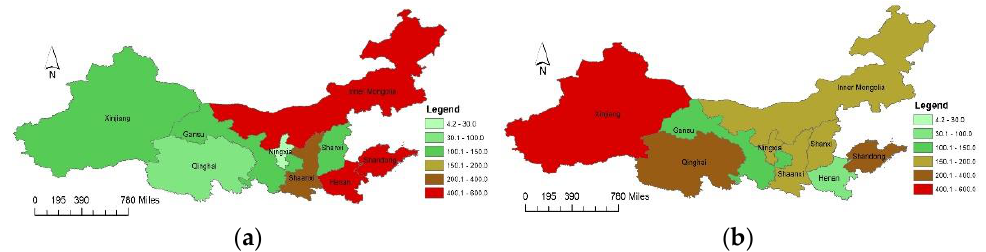
Figure 5. Virtual water trade of each province in the Yellow River Economic Belt (( a ) Total virtual water inflow and ( b ) Total virtual water outflow). Source: Authors’ own calculation / conception, based on MATLAB and ArcGIS software.